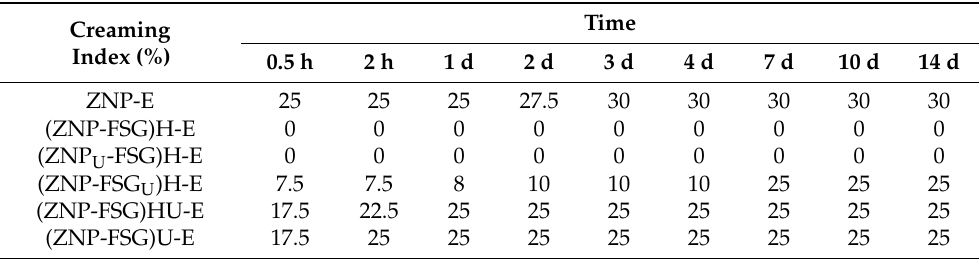
Table 2. The creaming index (%) of emulsions stabilized by ZNP-FSG complexes subjected to various ultrasound and homogenization